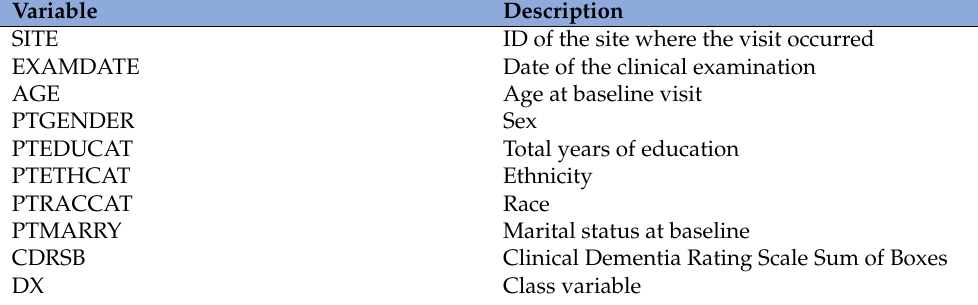
Table 1. Features